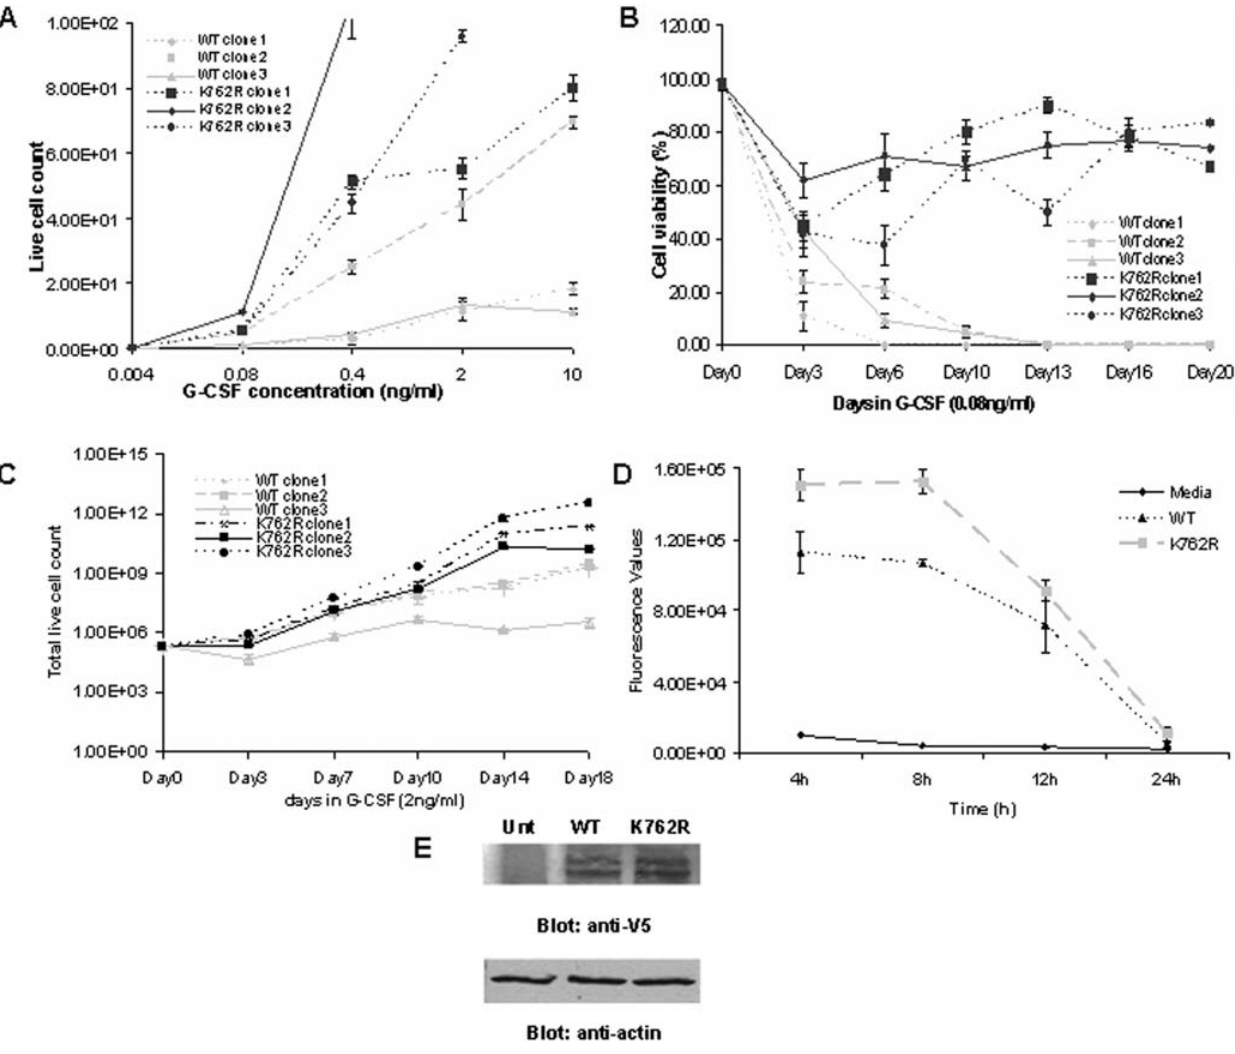
Figure 2. G-CSF hypersensitivity, hyperproliferation, and extended survival of transfected BaF3 cells expressing the K762R/G-CSFR mutant. (A) WT and K762R stable transfectants were grown in varying concentrations of G-CSF for 72 h and cell numbers counted. (B) WT and K762R stable transfectants were grown in 0.08 ng/ml of G-CSF for 20 days and cell viability determined by Trypan Blue staining. (C) Cells were grown in 2 ng/ml of G-CSF for 18 days and cell numbers counted. (D) Pooled transfectants were washed out of IL-3, grown in 10 ng/ml of G-CSF overnight, washed, and the viability of the cells measured over a period of 24 h using the CellTiter-Glo Luminescent Cell Viability Assay. Error bars indicating SEM from three independent experiments are shown. (E) Expression levels of the WT or the K762R G-CSFR were analyzed by Western blotting using anti- V5 antibody (upper panel). Untransfected parental BaF3 cells (Unt) were used as a negative control. The membrane in the upper panel was stripped and re-blotted with anti-actin antibody to confirm equal protein loading (lower